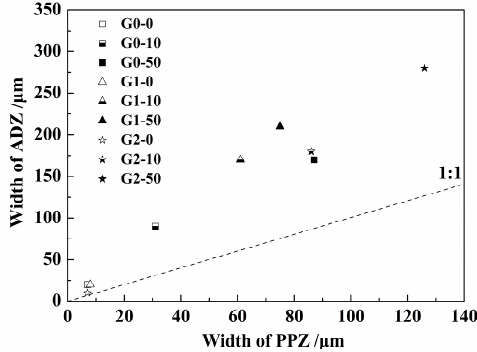
Figure 10. Relationship between the particle precipitation zone (PPZ) and the aluminum-depleted zone (ADZ) in the diffusion couple of G0, G1, and G2 before and after heat treatment at 1473 K.